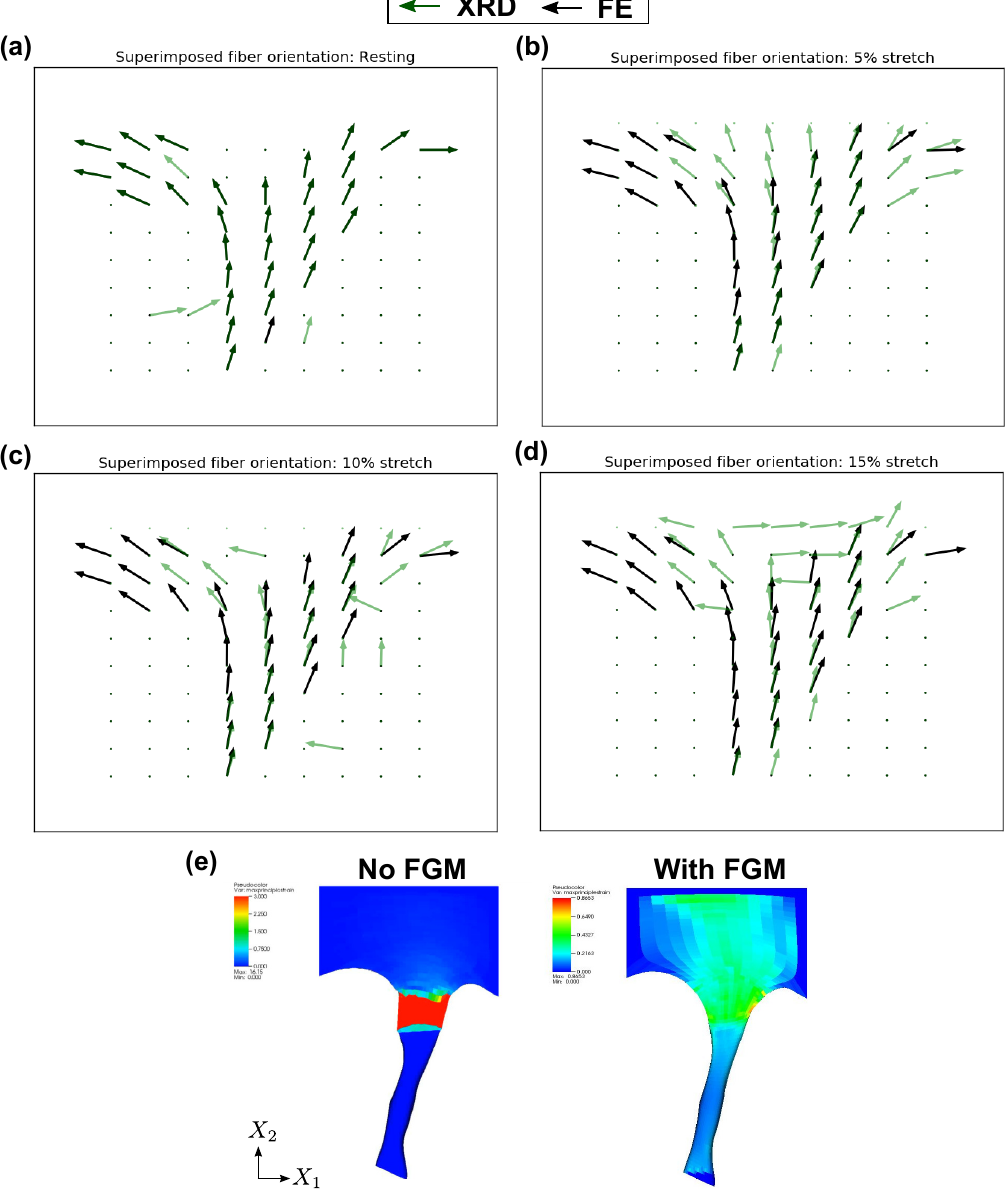
Figure 8. Local fiber orientation in the simulated CT–LL transition and the experimental data obtained from the analysis of the X-ray diffraction images in TV for ( a ) resting configuration, ( b ) 5% stretch, ( c ) 10% stretch and ( d ) 15% stretch. ( e ) Simulated strain distribution in the CT–LL transition in TV with hard transition without FGM (left) and with FGM (right) using Algorithm